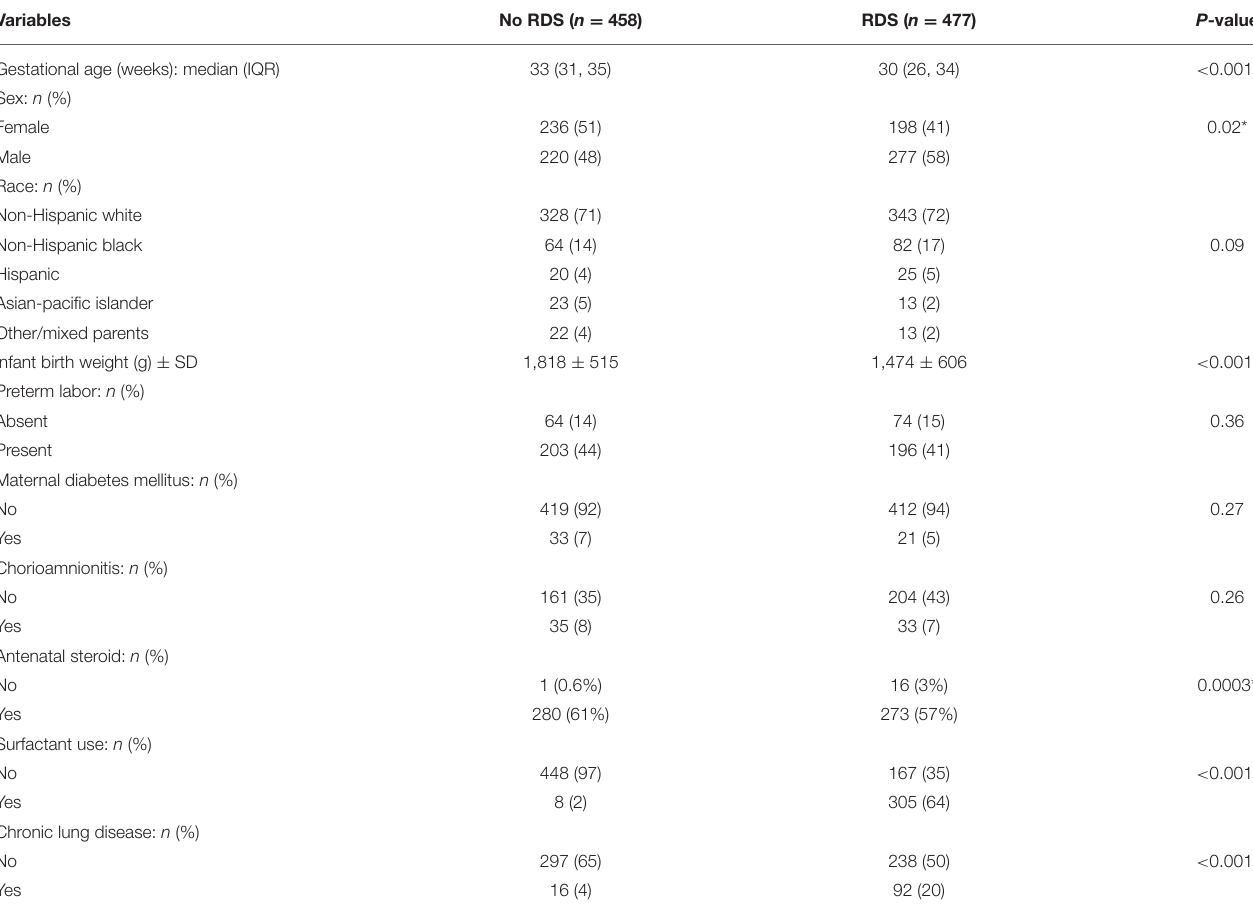
TABLE 1 | Clinical Characteristics of the cohort with and without